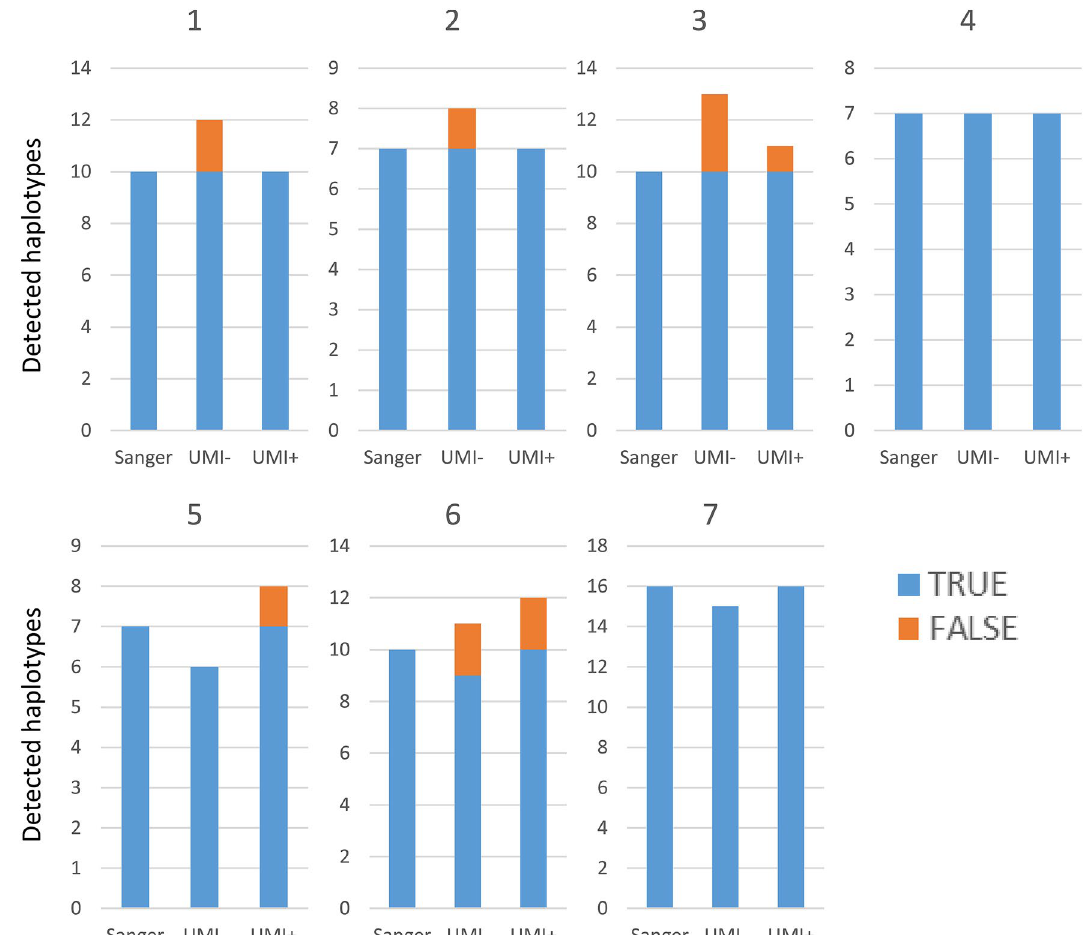
Figure 4. Number of detected haplotypes at optimal threshold. Number of haplotypes detected using a threshold of 0.2% with the UMI tags and 1.5% without the UMI tags; TRUE is the number of correct haplotypes detected; FALSE is the number of false haplotypes detected. Tank 1, 10 haplotypes for 11 individuals; Tank 2, 7 haplotypes for 7 individuals; Tank 3, 10 haplotypes for 11 individuals; Tank 4, 7 haplotypes for 7 individuals; Tank 5, 7 haplotypes for 7 individuals; Tank 6, 10 haplotypes for 10 individuals; Tank 7: 16 haplotypes for 17